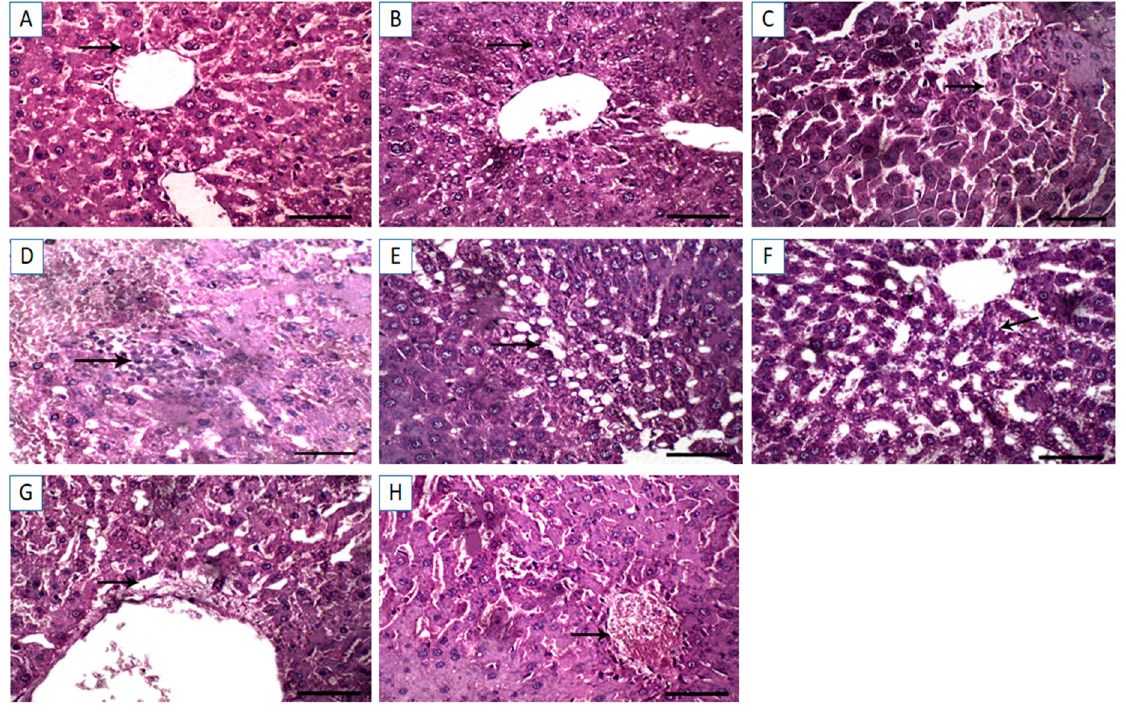
Figure 4. Light photomicrographs of hepatic tissues (sections stained with H&E). ( A , B ) control and cinnamon groups: Normal hepatocytes with normal radial arrangement around the central vein. ( C ) DFS group: Necrosis of the hepatocytes with dilatation of the hepatic sinusoids. ( D ) OTC group: Revealing massive hemorrhage replacing hepatic parenchyma and round cells infiltration. ( E ) DFS + OTC group: Vacuolation and necrosis of the hepatocytes. ( F ) DFS + Cin group: Showing remarkable amelioration of histopathological changes compared to DFS. ( G ) OTC + Cin group: Nearly normal hepatocytes with mild perivascular edema, and ( H ) DFS + OTC + Cin group: Hemorrhage replacing hepatic parenchyma. Scale bar = 100 µm.